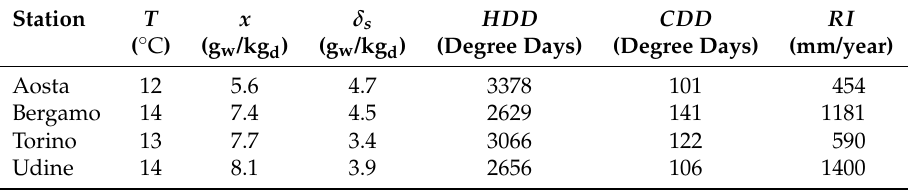
Table 3. Mean values of the weather variables for the last 6 years of the weather